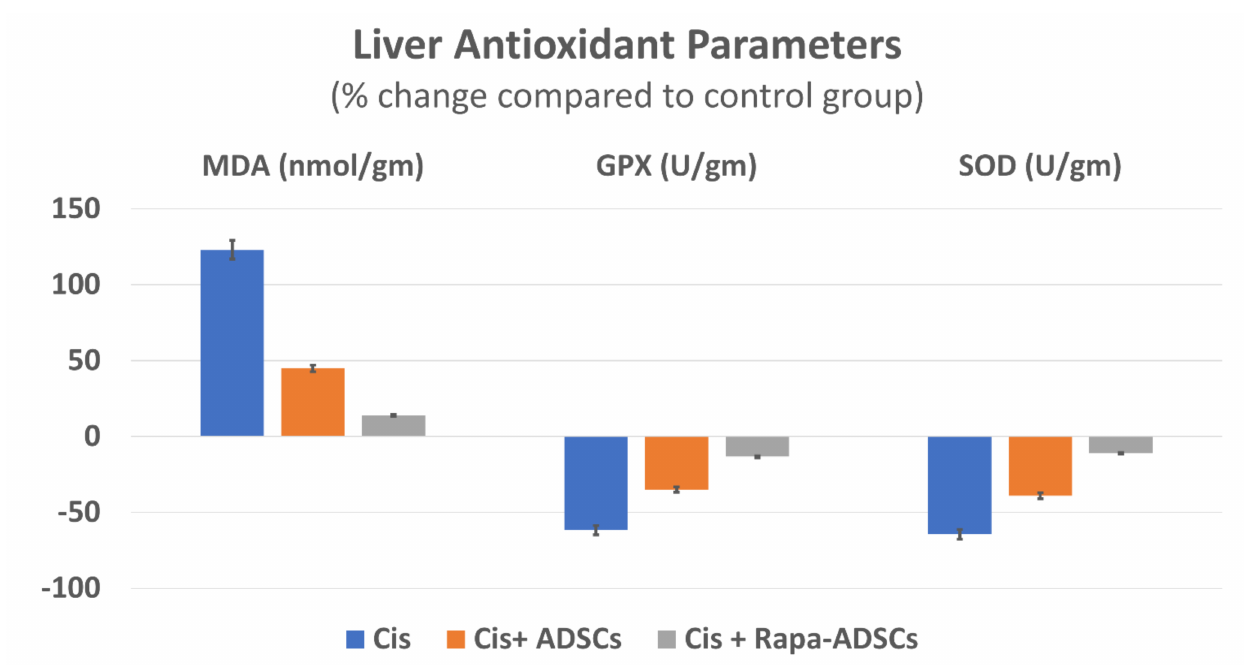
Figure 4. The effect of administering rapamycin-preconditioned ADSCs on liver antioxidant parameters, MDA, GPX and SOD, in cisplatin (Cis)-induced liver damage. Cis, cisplatin (i.p. injection of 5 mg/kg in 0.9% saline) group, Cis + ADSCs, cisplatin group receiving ADSCs (one million cells, intravenous in tail vein) and Cis + Rapa-ADSCs, cisplatin group receiving same number of ADSCs preconditioned with rapamycin (50 nM/L, 2 h prior to